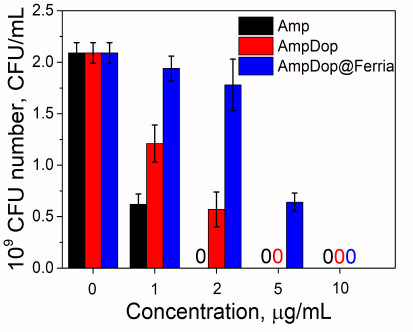
Figure 7. Antibiotic activity of